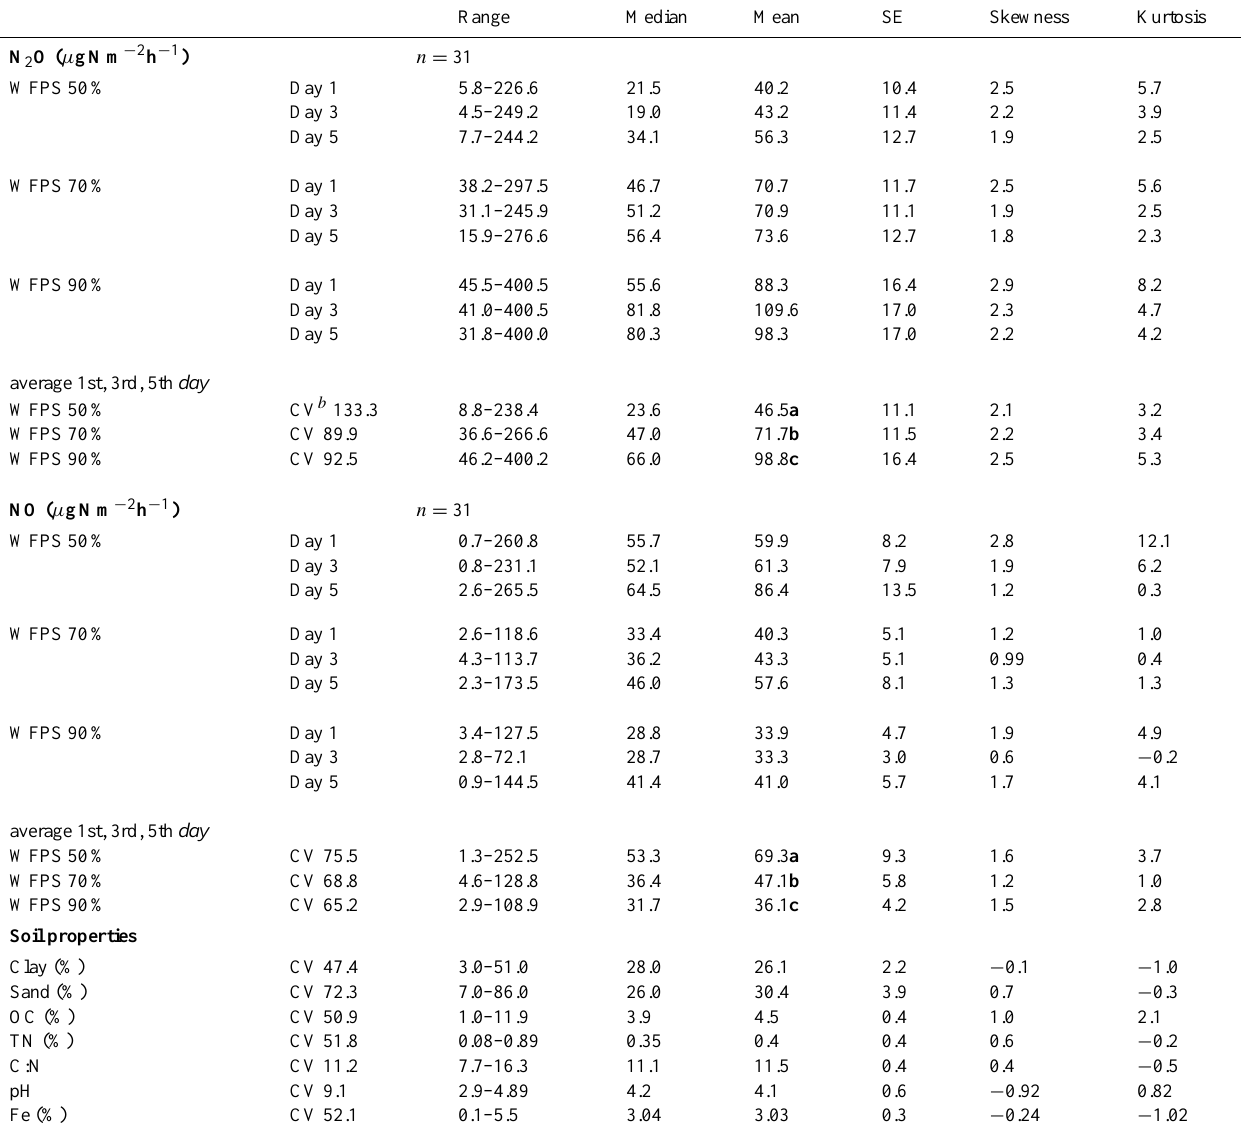
Table 1. Range, median, mean, standard error (SE), skewness and kurtosis of soil characteristics a , N 2 O and NO flux rates (measured at day 1, 3, and 5 after pre-incubation). The letters indicate significant differences ( P < 0 . 05) for mean N trace gas fluxes between different water-field pore space